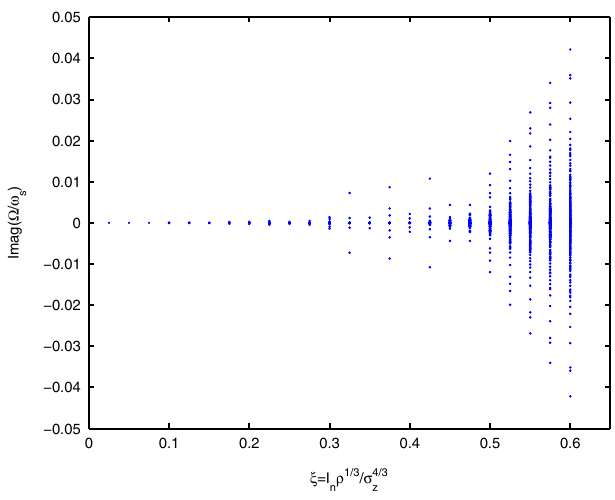
FIG. 9. Growth rates of all modes at various currents using the discretization method for the CSR impedance in free